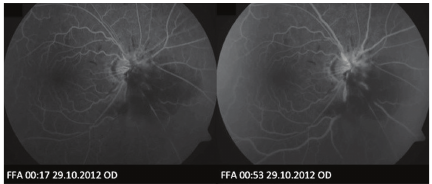
Figure 2: Fluorescein angiography (FA) of the right eye that does not demonstrate peripapillary leakage to suggest choroidal neovascularization (CNV) or hemorrhage. There is also no capillary fall-out to suggest retinal ischemia.